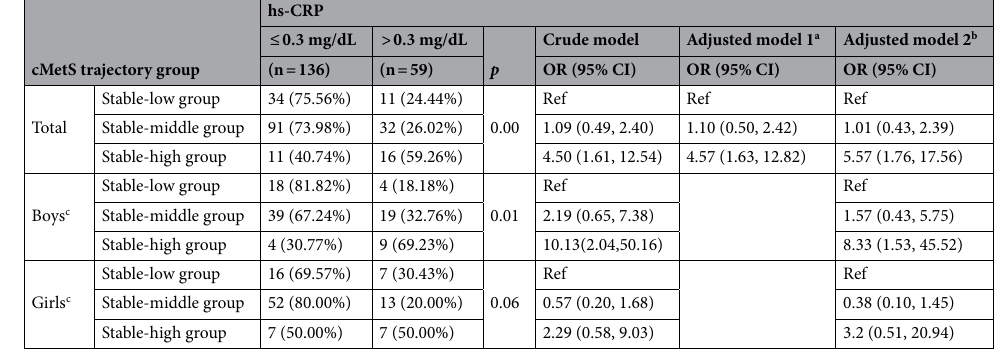
Table 4. Results of odds ratio for high hs-CRP risk according to cMetS trajectory groups. hs-CRP, High sensitivity C-reactive protein; OR, odds ratio; 95% CI, 95% confidence interval. a Model 1 was adjusted for sex. p for interaction with sex (0.02). b Model 2 was adjusted for sex, age, monthly household income, parental history of disease (CVD, cardiovascular diease; DYS, dyslipidemia; HTN, hypertension; DM, diabetes mellitus.), weekly vigorous-intensity physical activity, and secondhand smoking. p for interaction with sex(0.01). c For the sex-stratified analysis, we adjusted for all covariates except